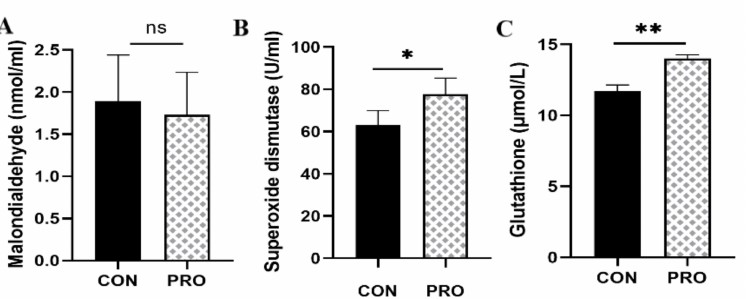
Figure 8. Effect of a multistrain probiotic preparation on fecal antioxidant capacity in healthy short- haired domestic cats. ( A – C ) Concentrations of malondialdehyde ( A ), superoxide dismutase ( B ), and glutathione ( C ) detected by commercial assay kits. Data are presented as mean ± SD. * p < 0.05; ** p < 0.01; ns, p > 0.05 compared with the control